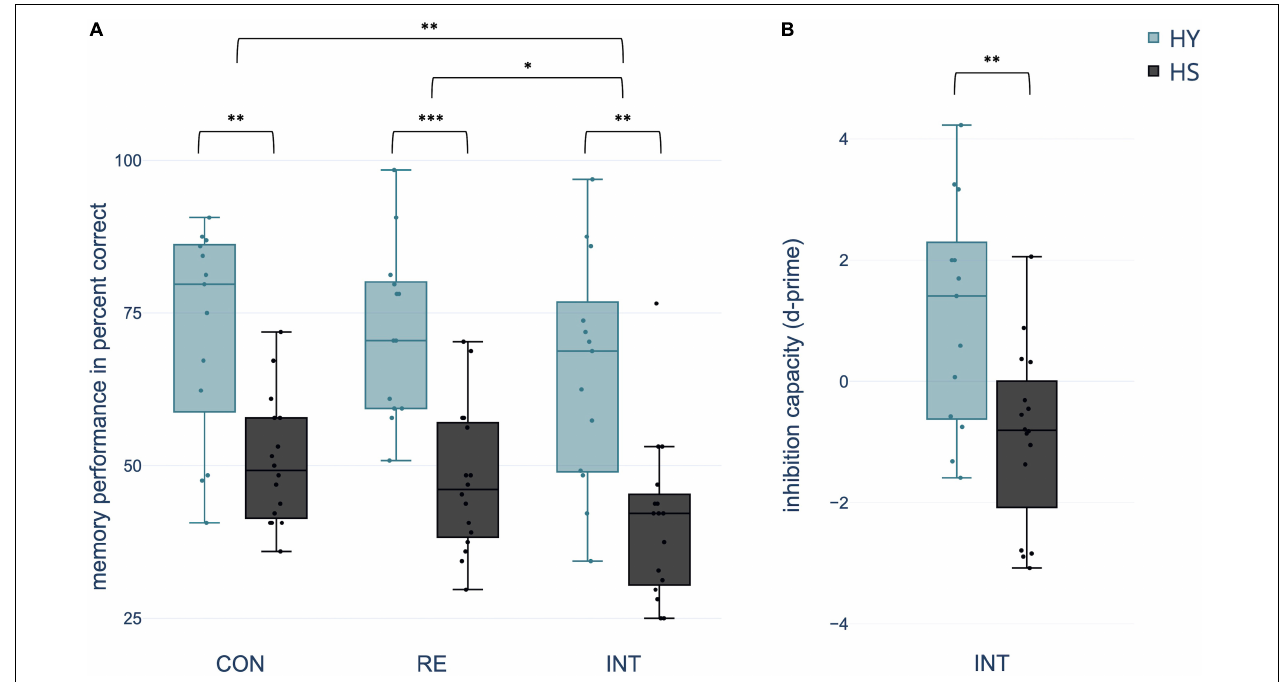
FIGURE 3 | Differences between groups and conditions (A) regarding spatial context memory performance in percent correct and (B) inhibition capacity operationalized in d -prime [z(correct retrieval)–z(intrusions)]. CON, control condition; RE, reminder condition; INT, interference condition; HY, healthy young; HS,